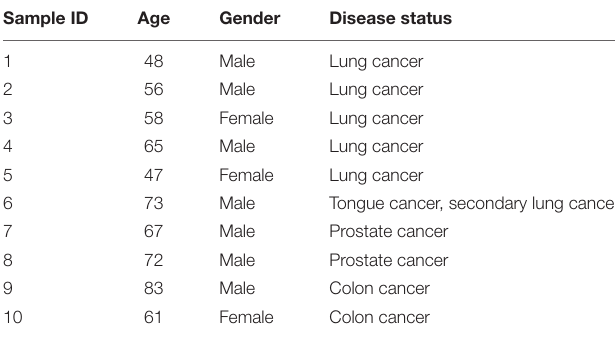
TABLE 1 | Patient information and clinical